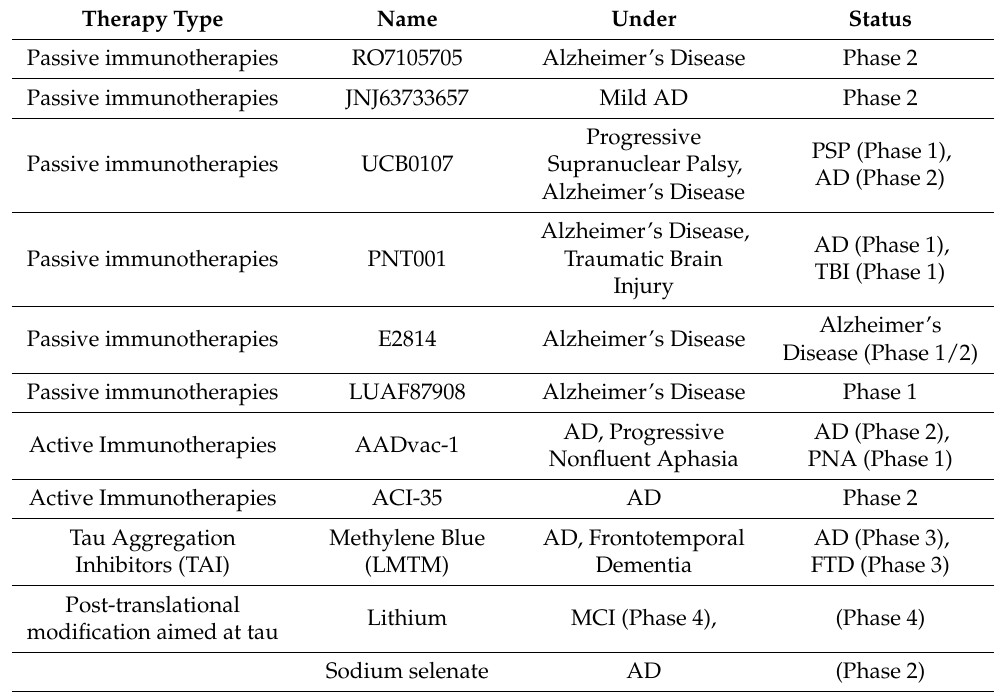
Table 3. Current ongoing clinical trial therapeutics of